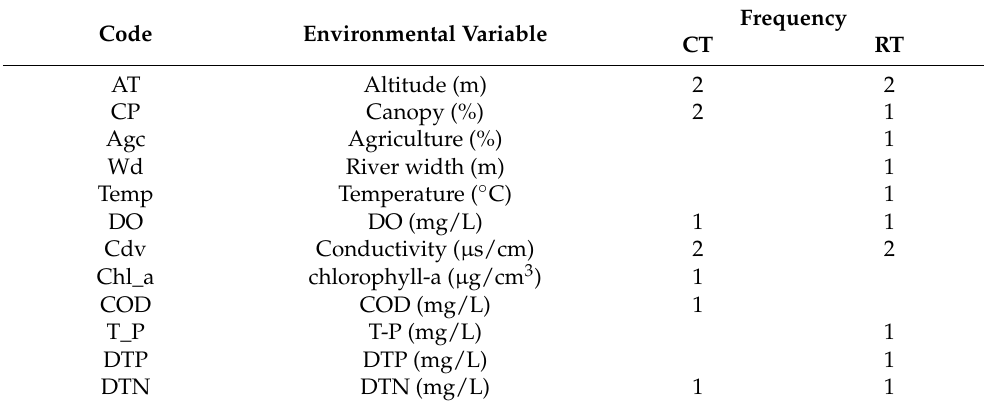
Table 7. The most common environmental variables used variables in the classification tree (CT) and regression tree (RT) analyses of six dominant species for decision making. Code Environmental